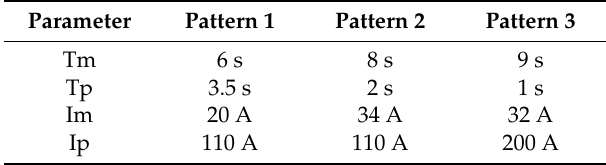
Table 1. Patterns definition for the discharge tests at variable